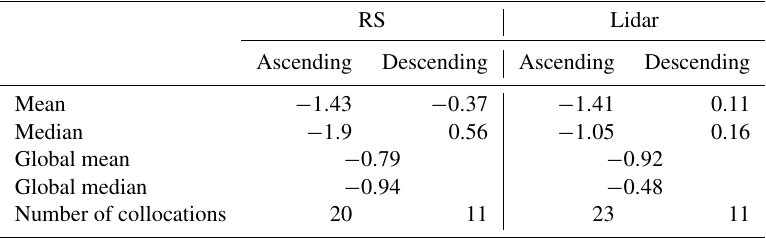
Table 4. Overview of the different statistics regarding the biases in Aeolus with respect to the reference instruments. The data used include all the collocations listed in Tables 1 and 2. RS Lidar Ascending Descending Ascending Descending Mean − 1 . 43 − 0 . 37 − 1 . 41 0.11 Median − 1 . 9 0.56 − 1 . 05 0.16 Global mean − 0 . 79 − 0 . 92 Global median − 0 . 94 − 0 . 48 Number of collocations